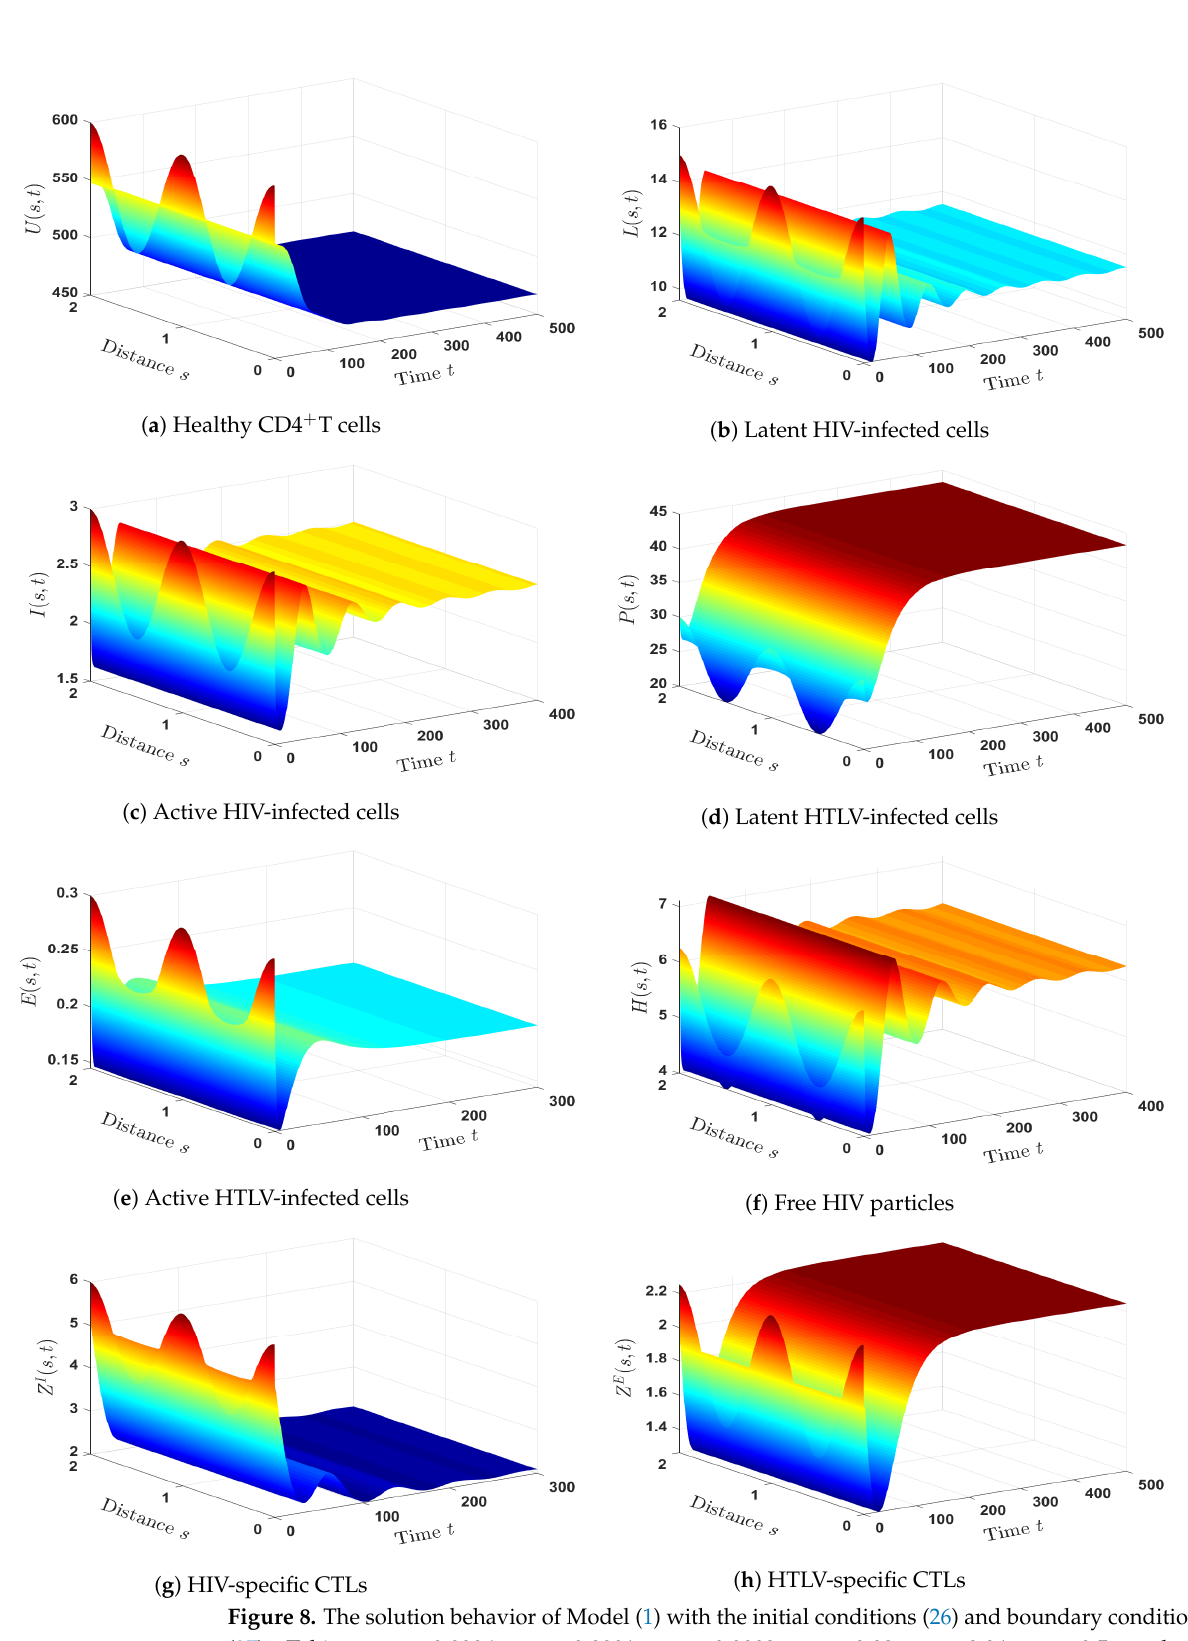
= ( 467.37,11.46,2.5,43.25,0.2,6.25,2.09,2.25 ) 7